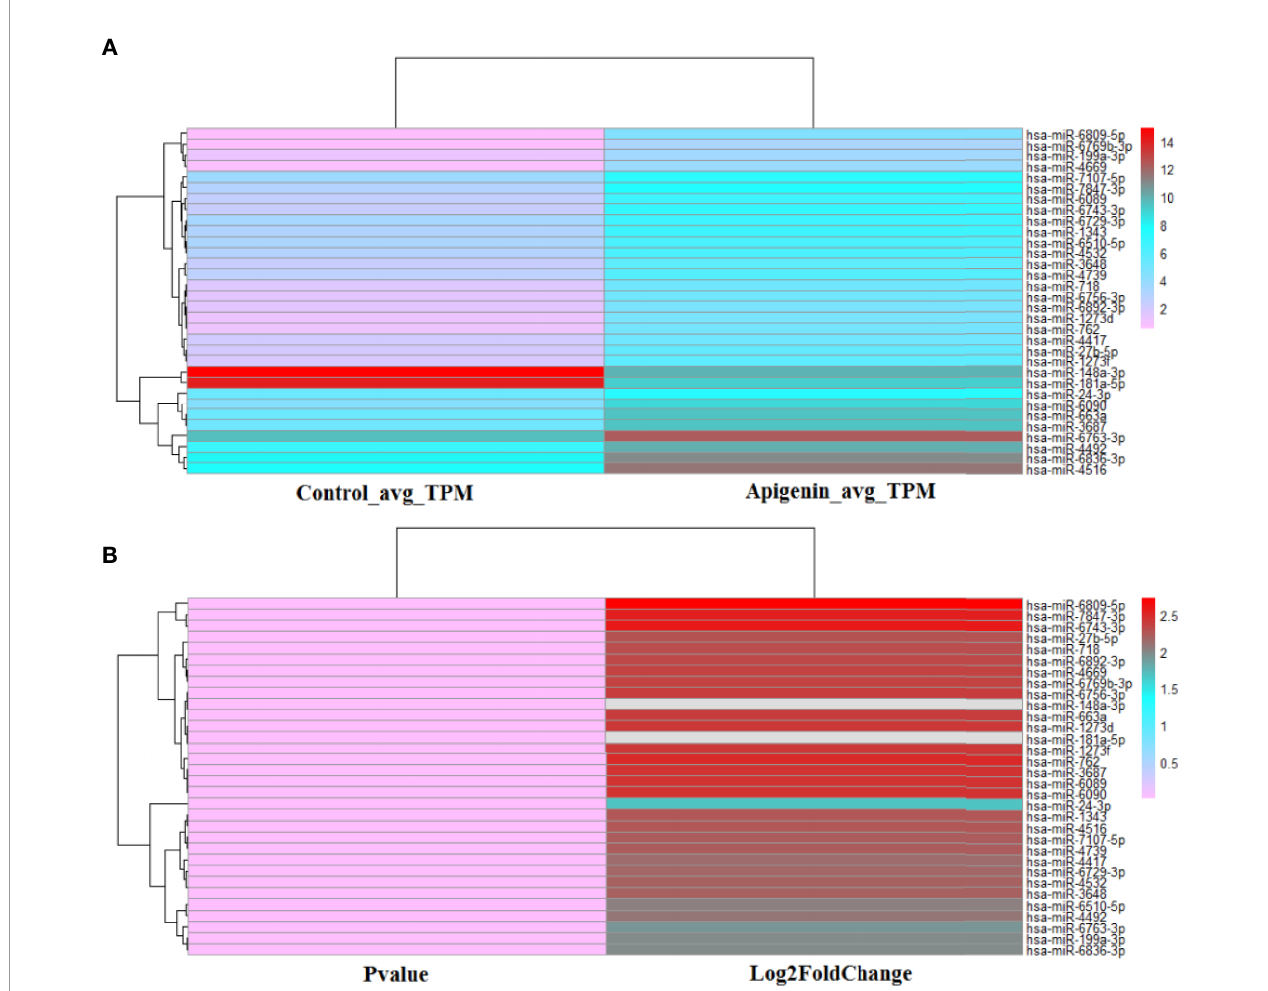
FIGURE 3 | The heat map of 32 top apigenin-modulated miRNAs in Huh 7 cells. (A) The hierarchical clustering analysis was performed to analyze the average TPM expression of miRNAs in Huh 7 cells treated with 10 µM apigenin vs. 0.1% DMSO. (B) The hierarchical clustering analysis was performed to analyze the P value and Log2Fold of the 32 top apigenin-modulated miRNAs (P value ≤ 0.001 ) . Red indicates high relative expression and pink indicates low relative